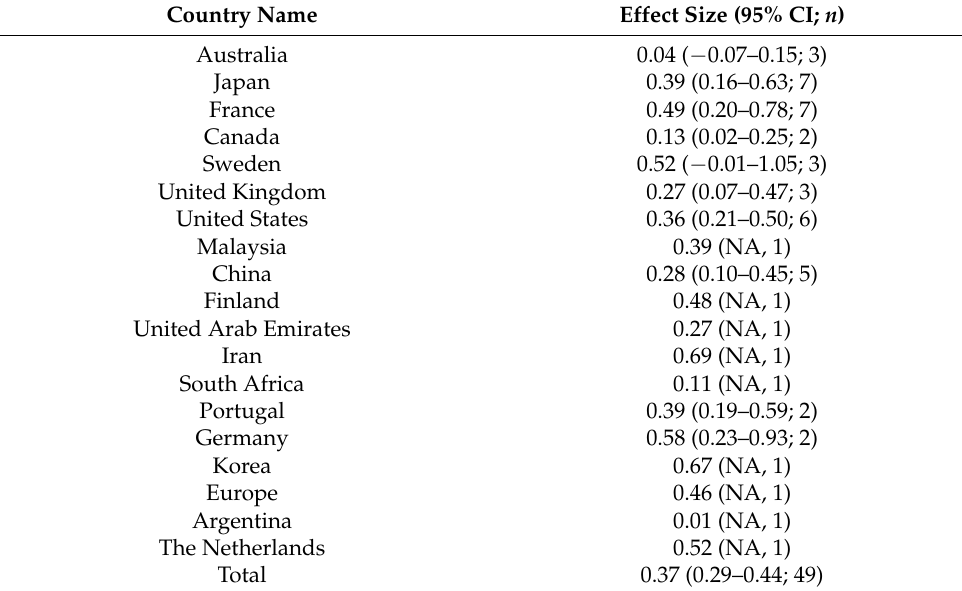
Table 3. Effect size (Cohen’s d) by country.